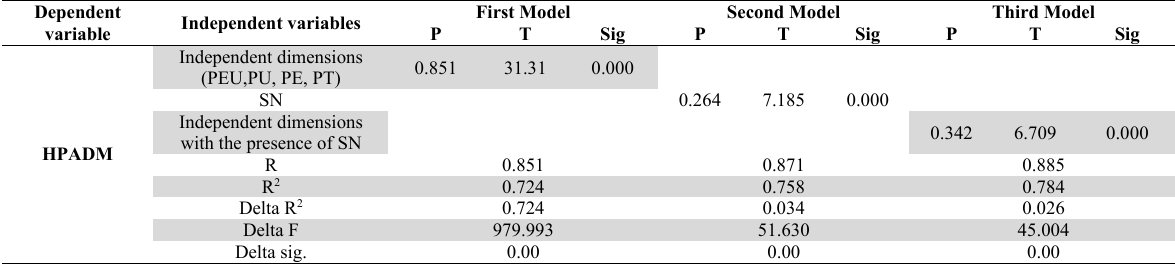
Results of hierarchical multiple regression analysis to show the impact of (PEU, PU, PE, PT) on HPADM in existence of subjective norms